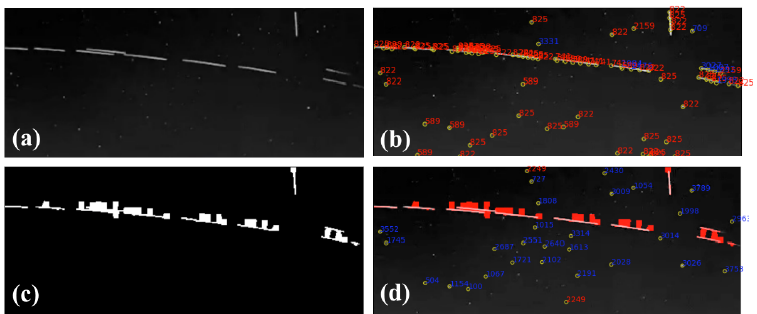
Figure 15. Linear interference by Starlink satellite: ( a ) the star image from Astronomical Observatory CCAF; ( b ) the extraction result with the Wavelet-LOF algorithm; ( c ) binary mask generated by proposed method; and ( d ) the result of star spot extraction with the mask. The red points indicate incorrect recognition, and the blue points indicate correct recognition.